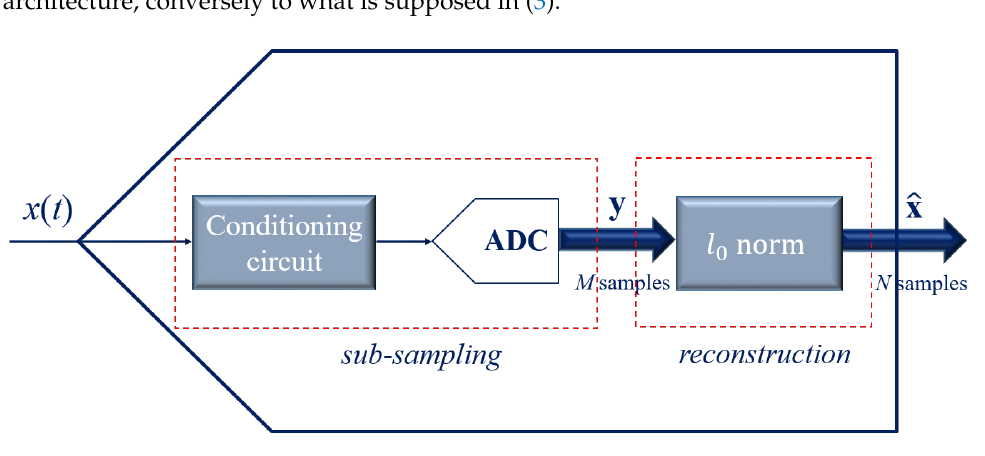
Figure 2. Generic framework of an AIC with its two sections: the acquisition front-end and the reconstruction